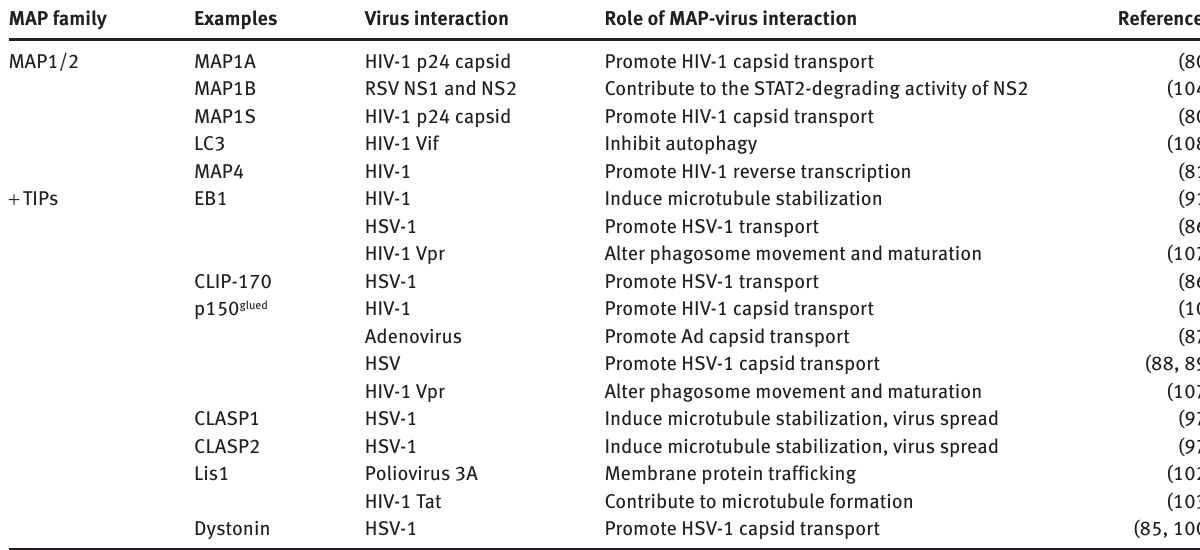
Table 1: Structural MAPs and + TIPs interact with several different viruses. MAP family